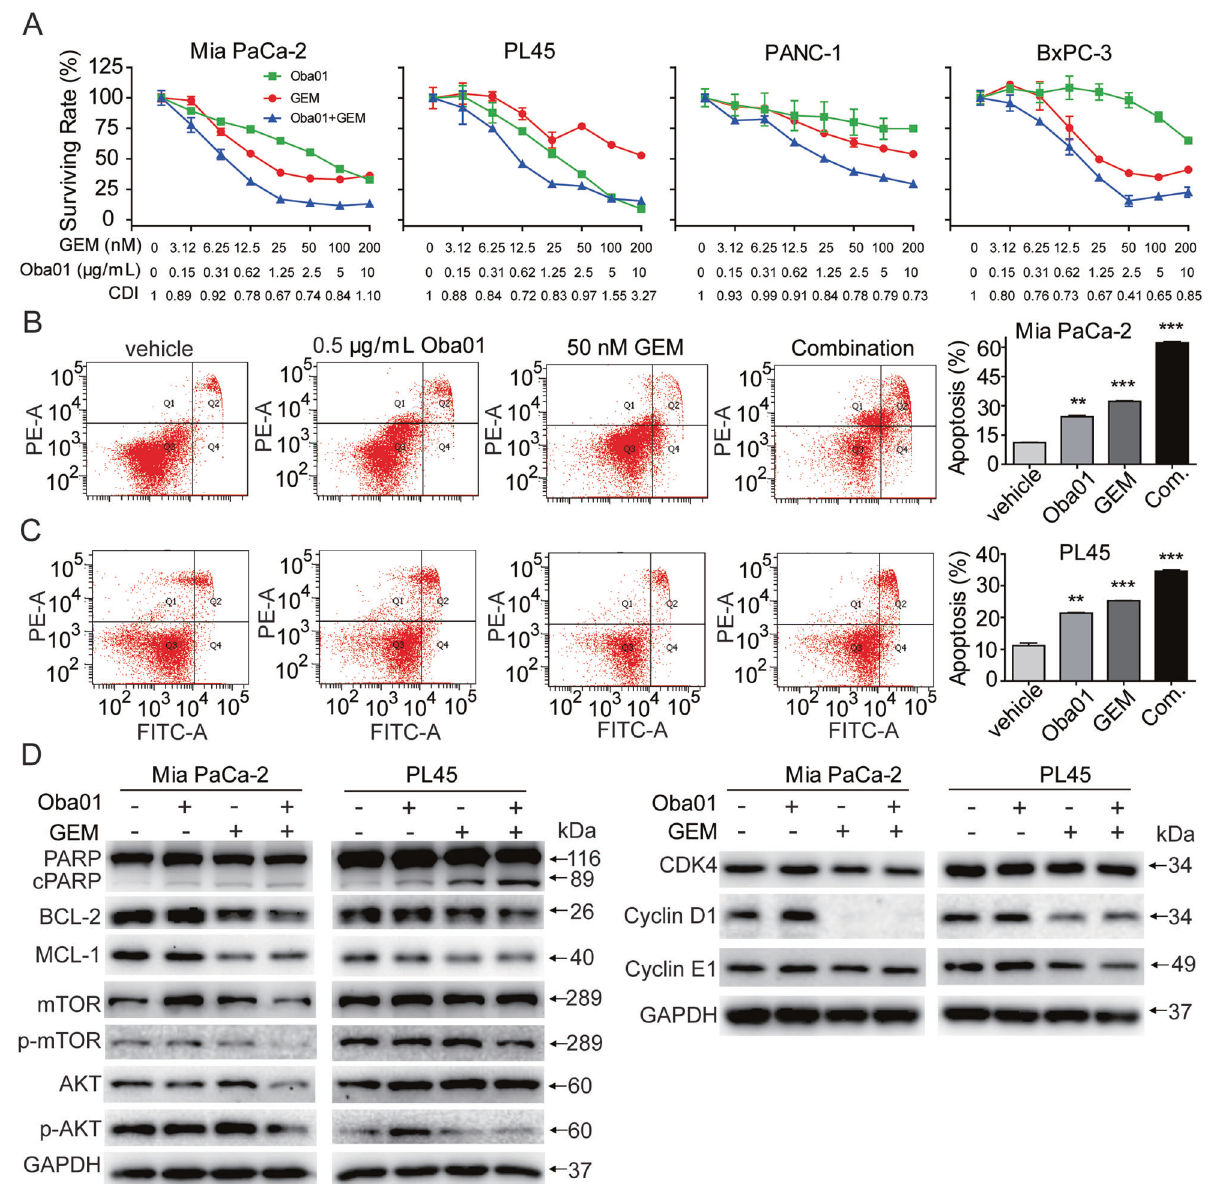
Fig. 5 Cell apoptosis induced by Oba01 and/or gemcitabine in DR5-positive pancreatic cancer cells. A Cytotoxicity of a combination with Oba01 and gemcitabine (GEM) in a panel of PC cell lines as determined by CellTiter-Glo ® Assay in accordance with the manufacturer ’ s instructions. All results are presented as the mean of three independent experiments ± SD. CDI <1 represents a synergistic effect. B , C Mia PaCa-2 and PL45 cells were treated with Oba01, GEM, or their combination (Com.) for 48 h. The cells were stained with an anti-Annexin V-FITC antibody and PI for apoptosis analysis by fl ow cytometry. Annexin V-FITC-positive cells were de fi ned as apoptotic. D Mia PaCa-2 and PL45 cells were treated with the indicated concentrations of Oba01 and GEM or their combination for 48 h. The cell lysates were subjected to immunoblotting analysis with antibodies to p-AKT, AKT, P-mTOR, mTOR, BCL-2, MCL-1, PARP, CDK4, CDK4, Cyclin D1, Cyclin E1, or with antibodies to GAPDH as the loading